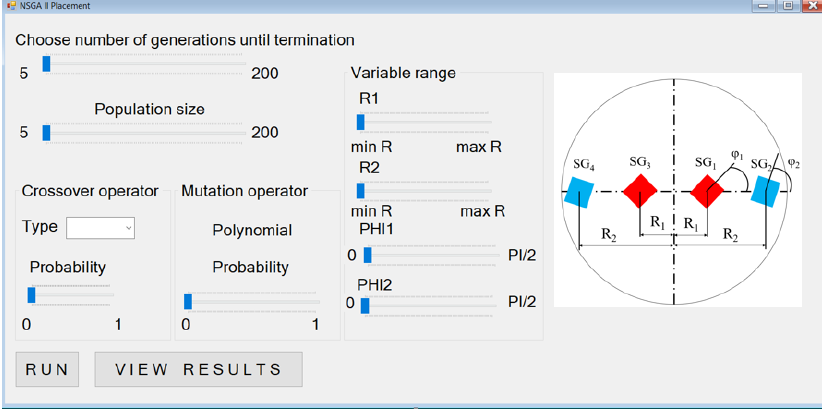
Fig. 7 . User interface of the module for managing algorithm